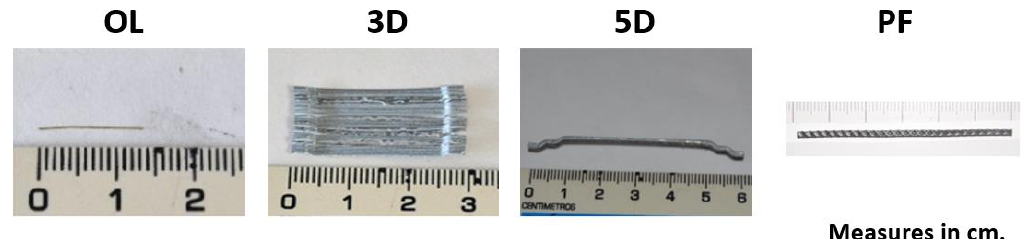
Figure 1. Appearance and length of the fibres used.